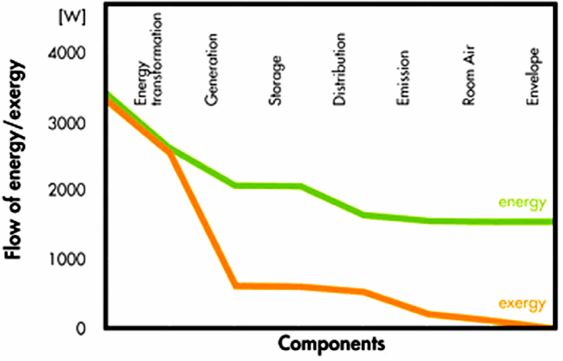
Figure 1. Energy and exergy flux through the building energy chain (adapted from [3]) with permission from the Fraunhofer Institute for Building Physics,